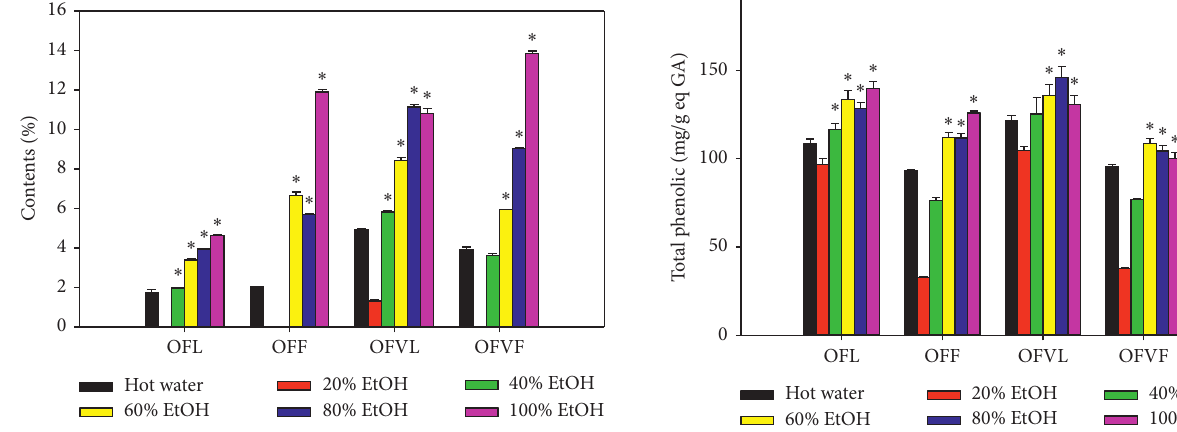
Figure 6: Total phenolics of various extracts of Osmanthus fragrans ( n � 3; ∗ significantly higher than the “hot water”